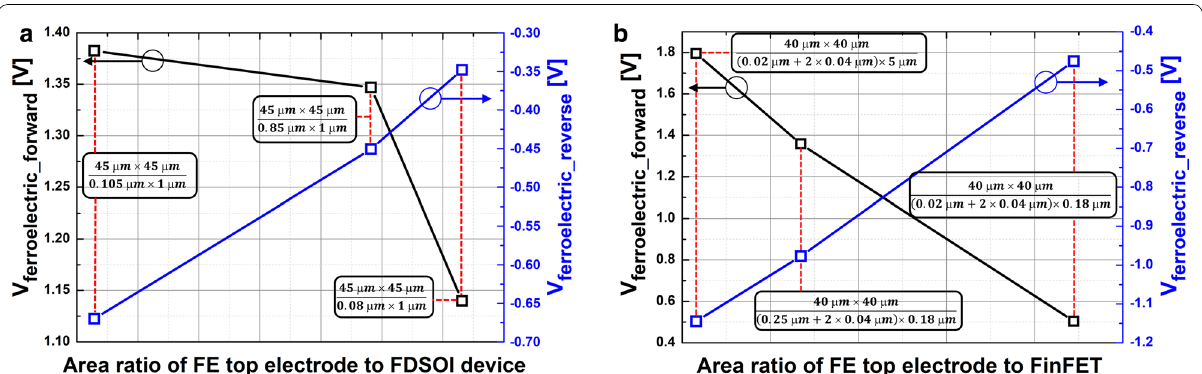
Fig. 9 Measured voltage across the ferroelectric capacitor during forward sweep and reverse sweep vs. the area ratio of ferroelectric capacitor top electrode to a FDSOI device, b